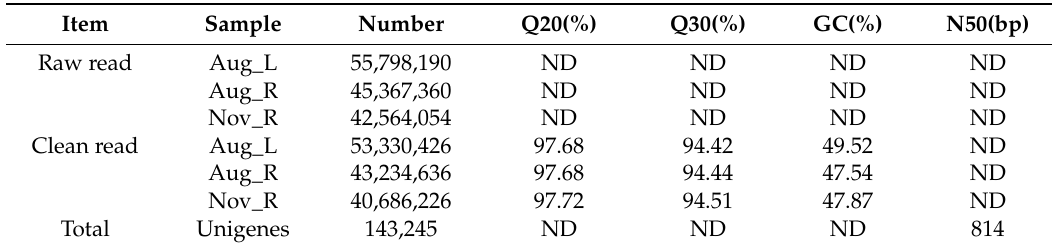
Table 1. Summary of the sequencing